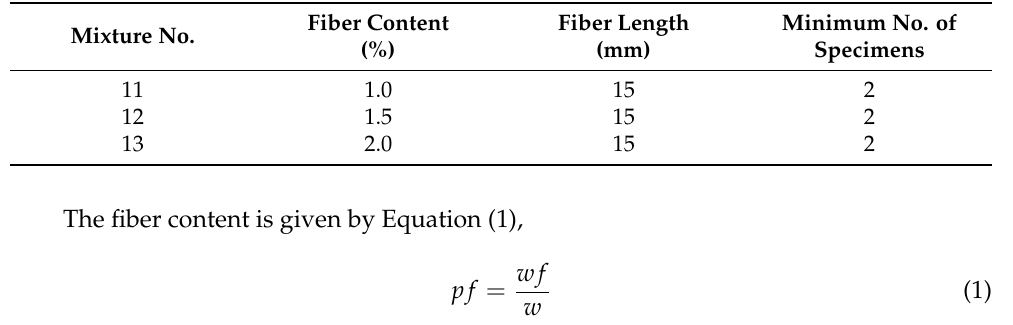
Table 4. Soil–fiber mixtures.